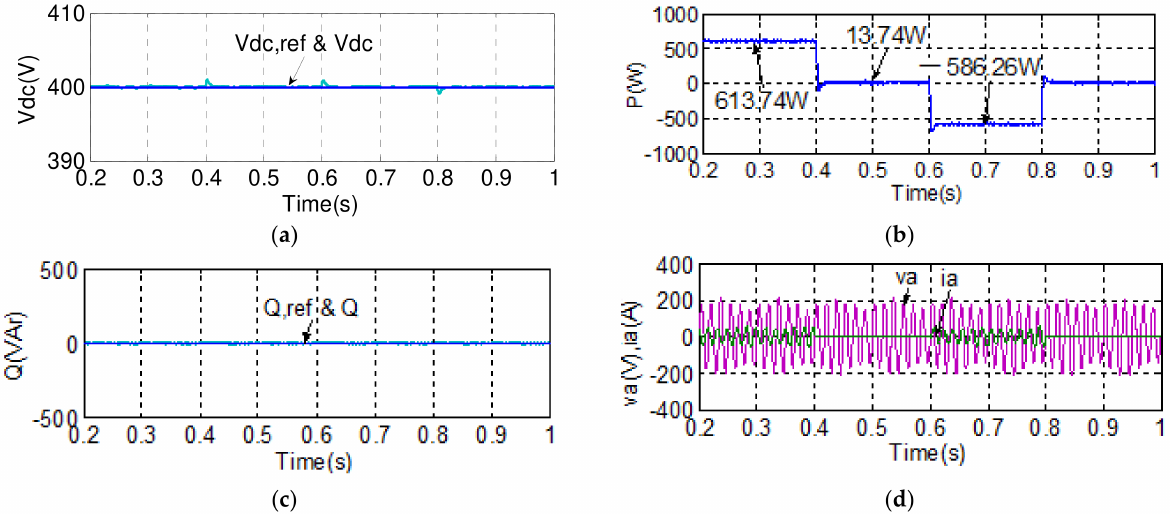
Figure 17. Simulated grid inverter waveforms in case 2: ( a ) DC link voltage and reference; ( b ) active power; ( c ) reactive power and reference; ( d ) phase-a voltage and